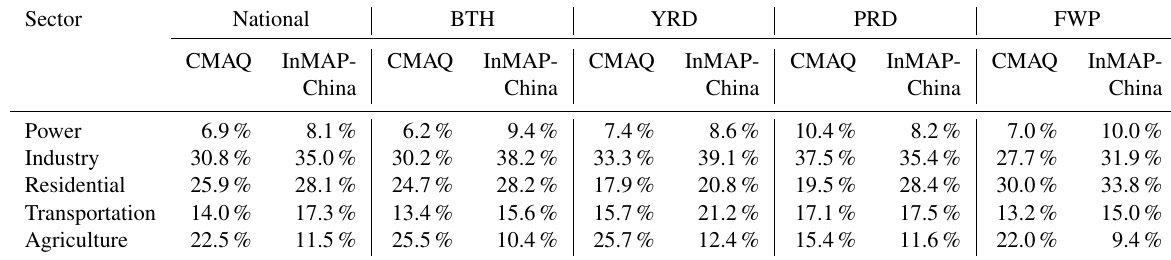
Table 4. Comparison of the proportions of sectoral contributions to PM 2 . 5 concentrations using InMAP-China and CMAQ. Sector National BTH YRD PRD FWP CMAQ InMAP- CMAQ